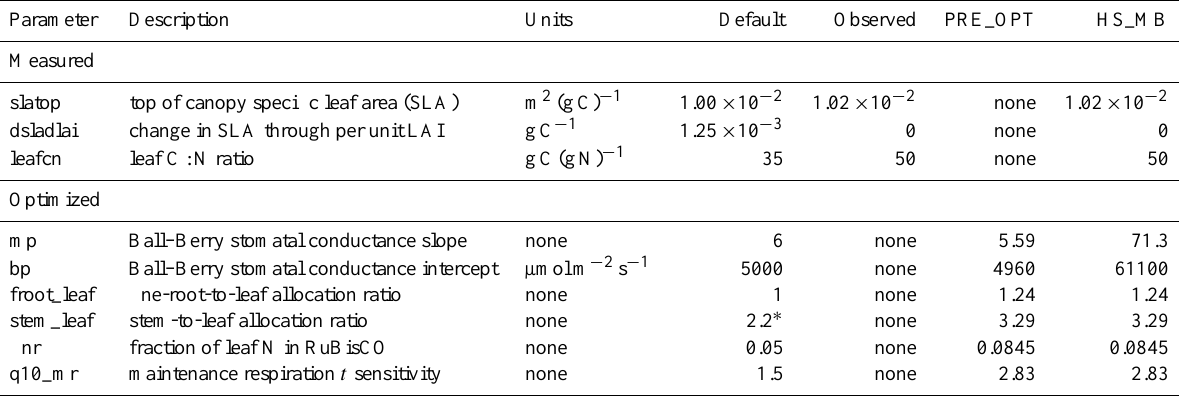
Table 1. Default PFT-level, site-specific, and optimized parameters for the PiTS site used in CLM 4.0. PFT-level parameters are for the temperate evergreen needleleaf forest type. Optimized values were obtained using the pretreatment data (PRE_OPT) and for the transpiration data during the shading period (HS_MB). In the HS_MB optimization, only the mp and bp parameters were optimized, while other parameters retain their pretreatment optimization